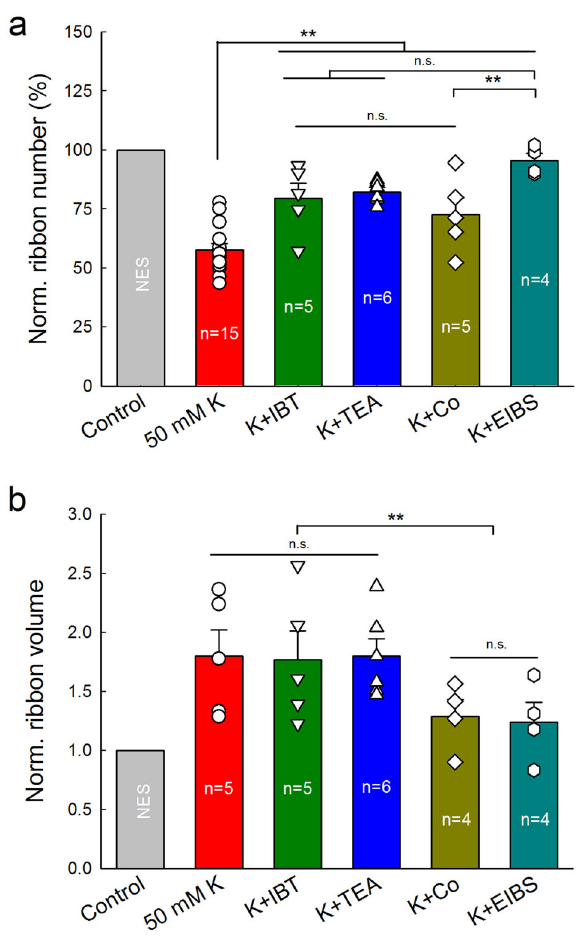
Fig. 5 Comparison of attenuations of blockage of K + and Ca ++ channels on K + -induced IHC ribbon degeneration and swelling. Ribbon numbers and volumes in the K + (50 mM) group, K + + IBT (0.1 μ M) group, K + + TEA (20 mM) group, K + + Co ++ (2 mM) group, and K + + EIBS group were normalized to those in the NES control group. N is the number of mice. a Both K + and Ca ++ channel blockers attenuate ribbon degeneration. b Ca ++ channel blocker but not K + channel blockers attenuates ribbon swelling. n.s. no signi fi cance ( P > 0.05); ** P < 0.01, one-way ANOVA with a Bonferroni